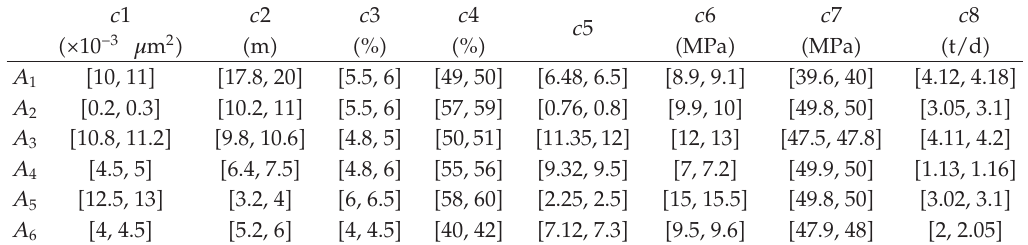
Table 2: Several characteristic parameters of six alternatives for refracturing. c 1 c 2 c 3 c 4